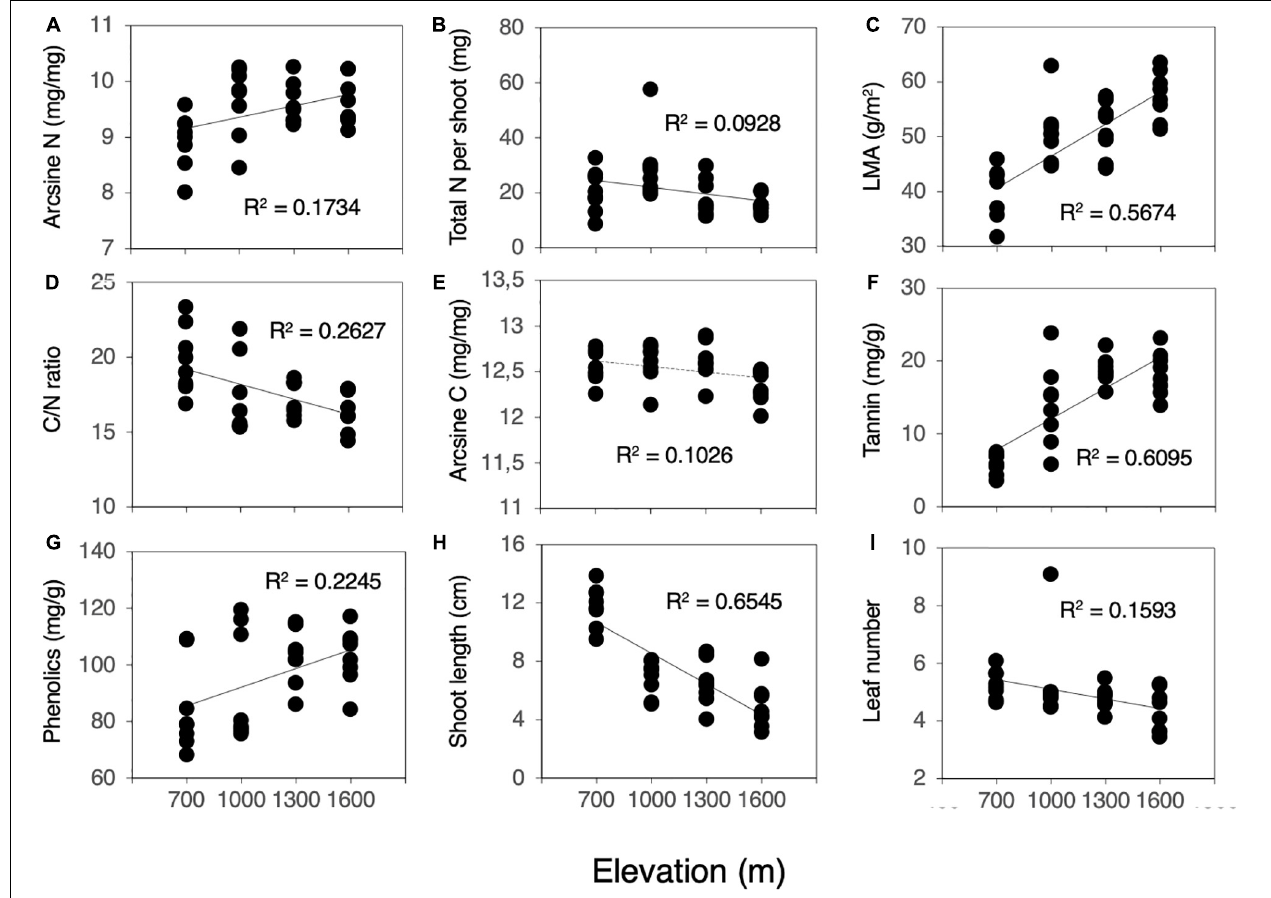
FIGURE 2 | Correlation between plant characteristics (leaf traits and plant growth) and elevation ( n = 32). (A) N, (B) Total N per shoot, (C) LMA, (D) C/N ratio, (E) C, (F) Condensed tannin, (G) Total phenolics, (H) Shoot length, and (I) Number of leaves per shoot. The y -axis in (A,E) shows arcsine (n)-transformed N and C contents. Solid lines denote significant correlation, and dashed lines denote marginal significant correlation.